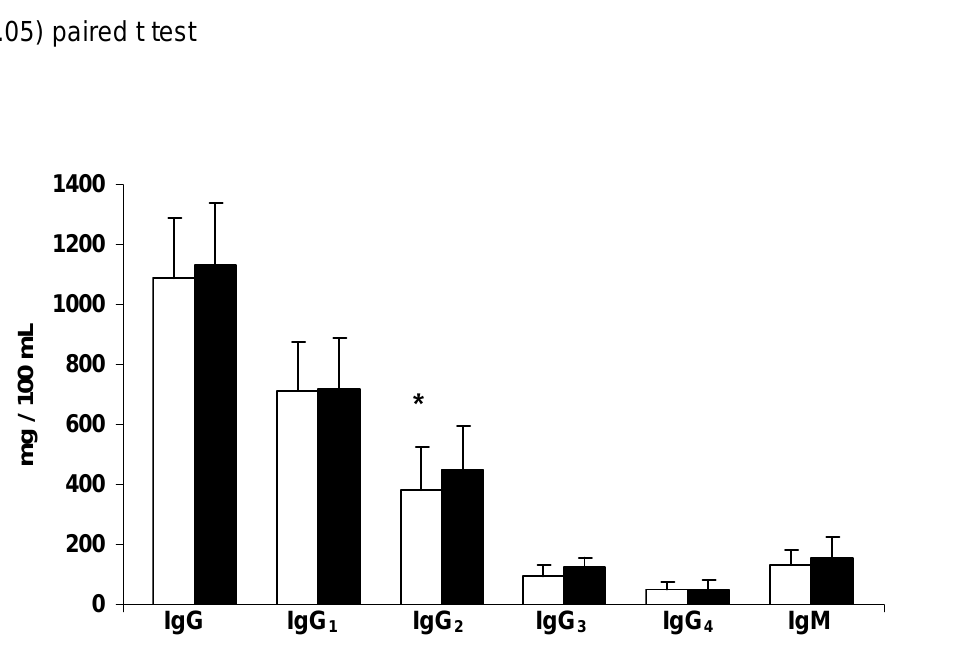
Figure 2: IgG and subclass serum levels in patients evaluated before and after 14 days of treatment with rabies serum vaccination. Results are expressed as mean + SD of mg/100 ml.